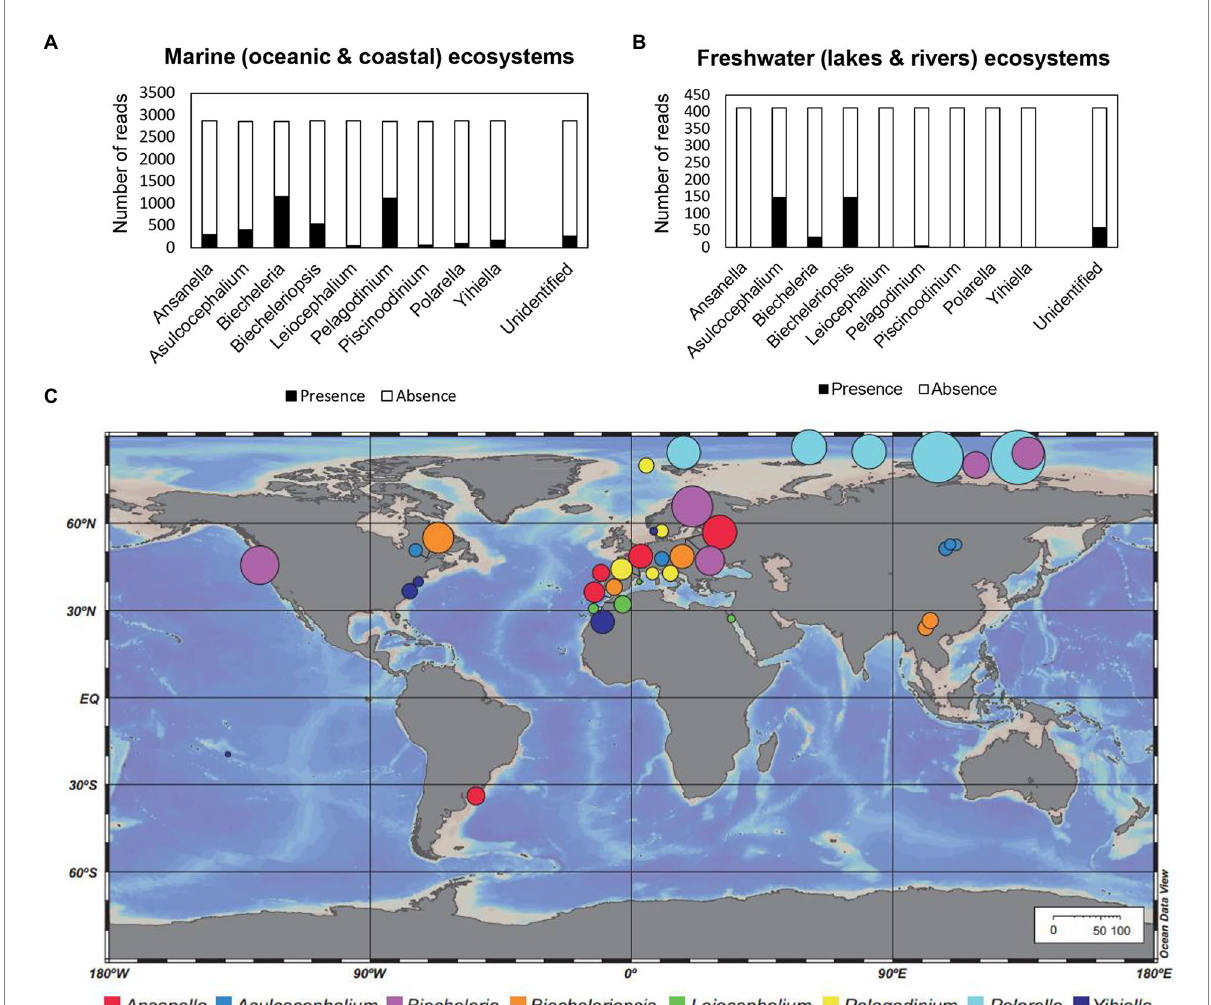
FIGURE 2 Number of reads in the metaPR 2 dataset annotated to each genus (family Suessiaceae) among the samples collected from (A) marine (oceanic and coastal) and (B) freshwater (lakes and rivers) ecosystems. (C) Distribution map showing the five samples with the highest abundance of each genus among the surveyed samples. The diameter of each circle (based on the scale bars) represents the percentage (%) of reads belonging to each genus within the entire protist